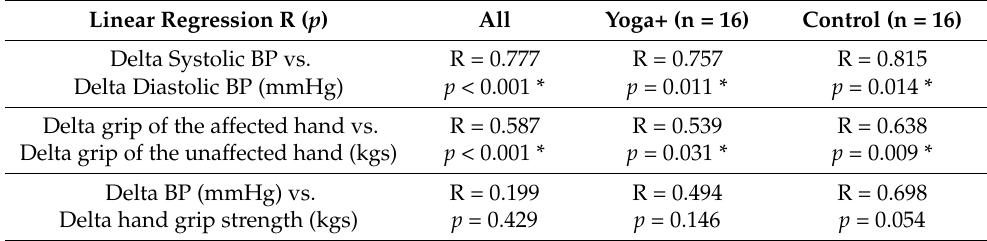
R = 0.777 R = 0.757 p < 0.001 * p = 0.011 * R = 0.587 R = 0.539 p < 0.001 * p = 0.031 * R = 0.199 R = 0.494 p = 0.429 p = 0.146